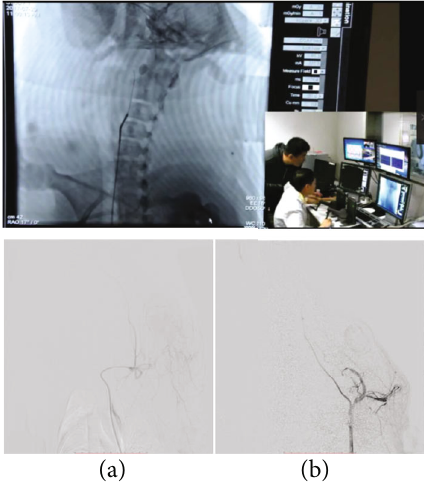
Figure 5: (a, b) The images of porcine cerebral angiography,